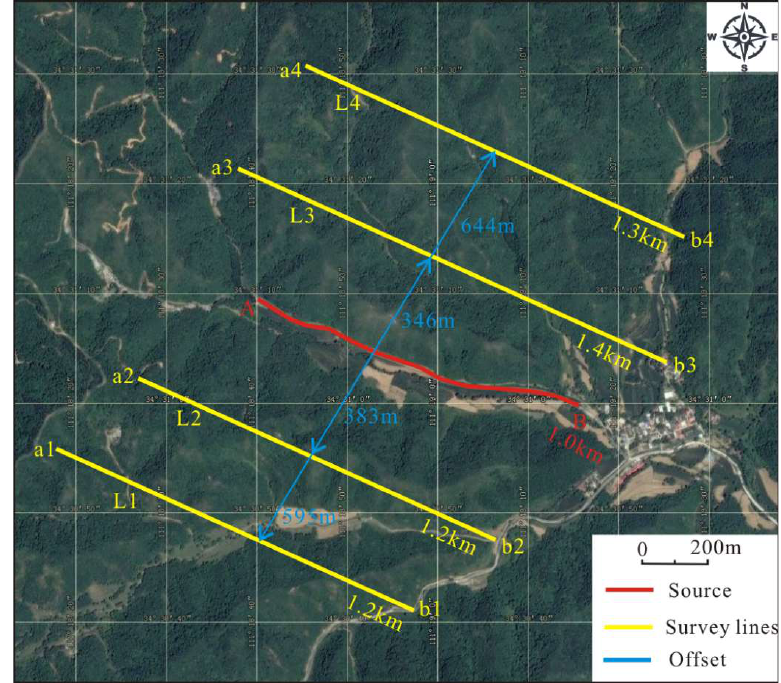
Figure 5. Layout of the transmitting source and survey lines.